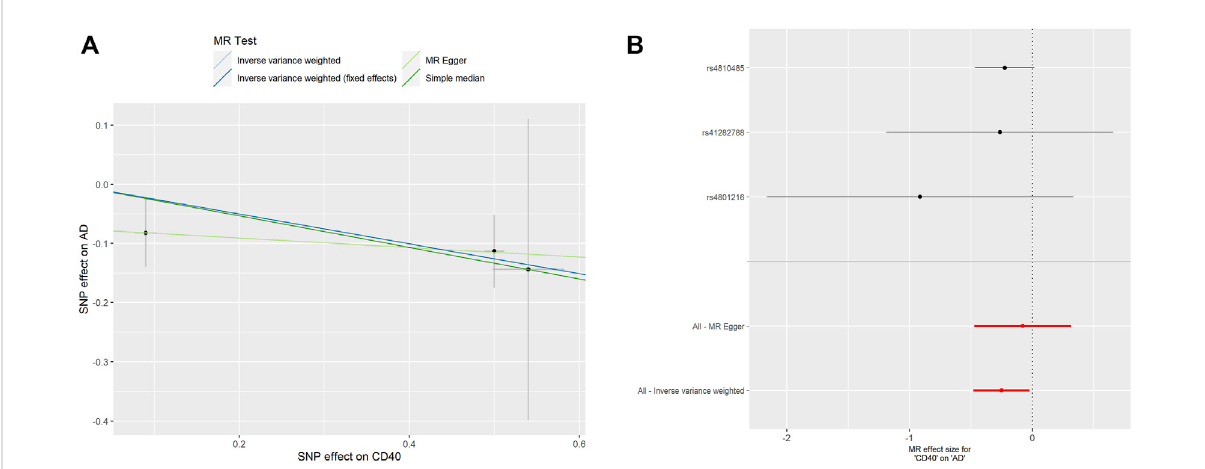
FIGURE 2 MR analyses of genetic proxied CD40 levels on the risk of AD. The scatterplot (A) and the forest plot (B) of the MR analysis of CD40 and AD. AD, aortic dissection; MR, Mendelian